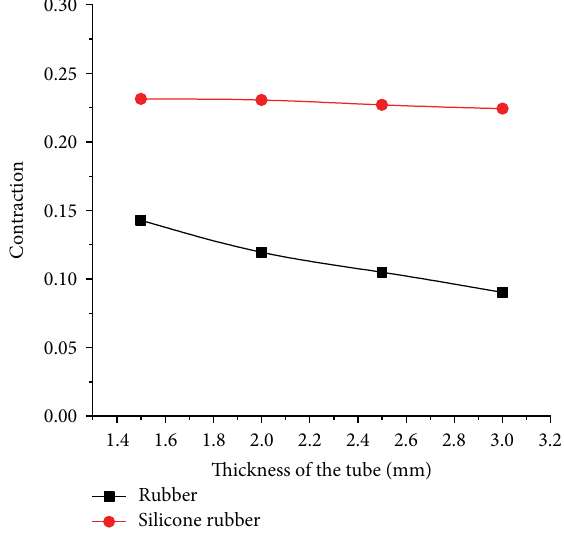
Figure 13: Contraction ratios of the PAMs with different wall thicknesses and materials under the pressure of 0.3 MPa and the load of 200